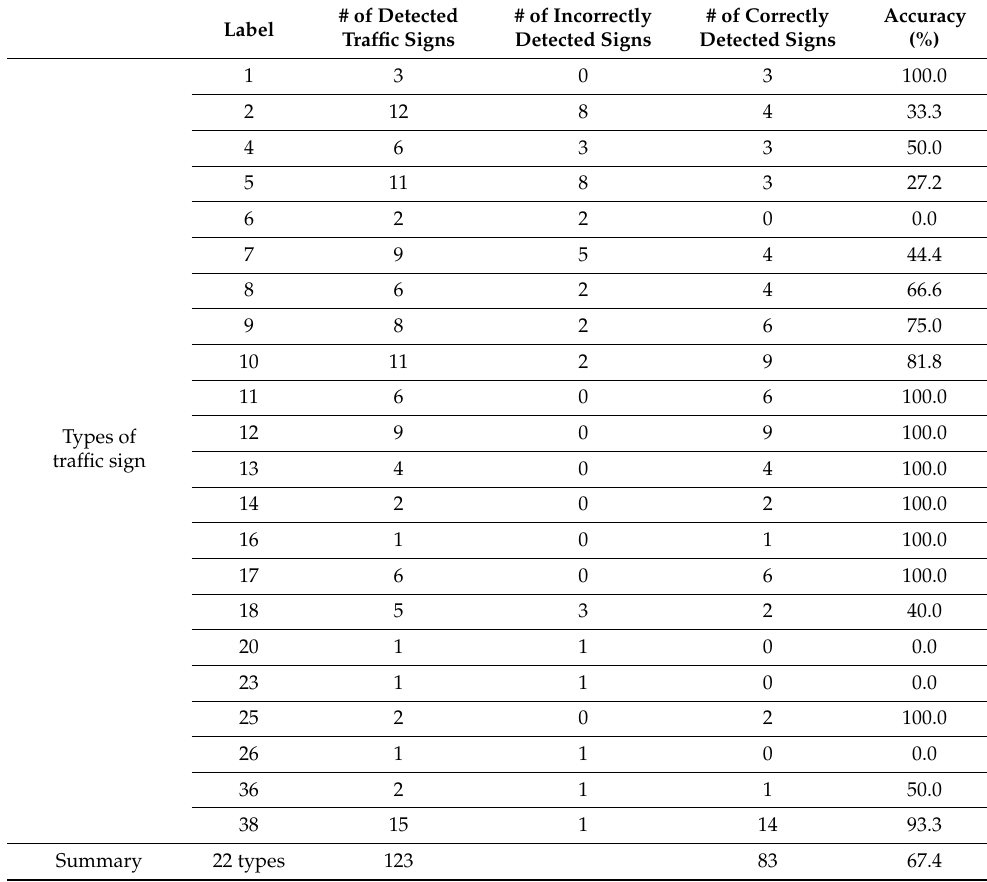
Table 6. Traffic sign recognition results of YOLOv6 using GTSDB.